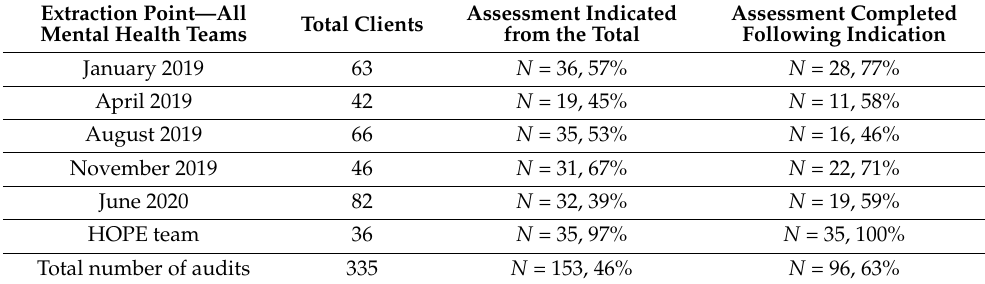
Table 3. Comparing extraction points of assessments indicated and assessments